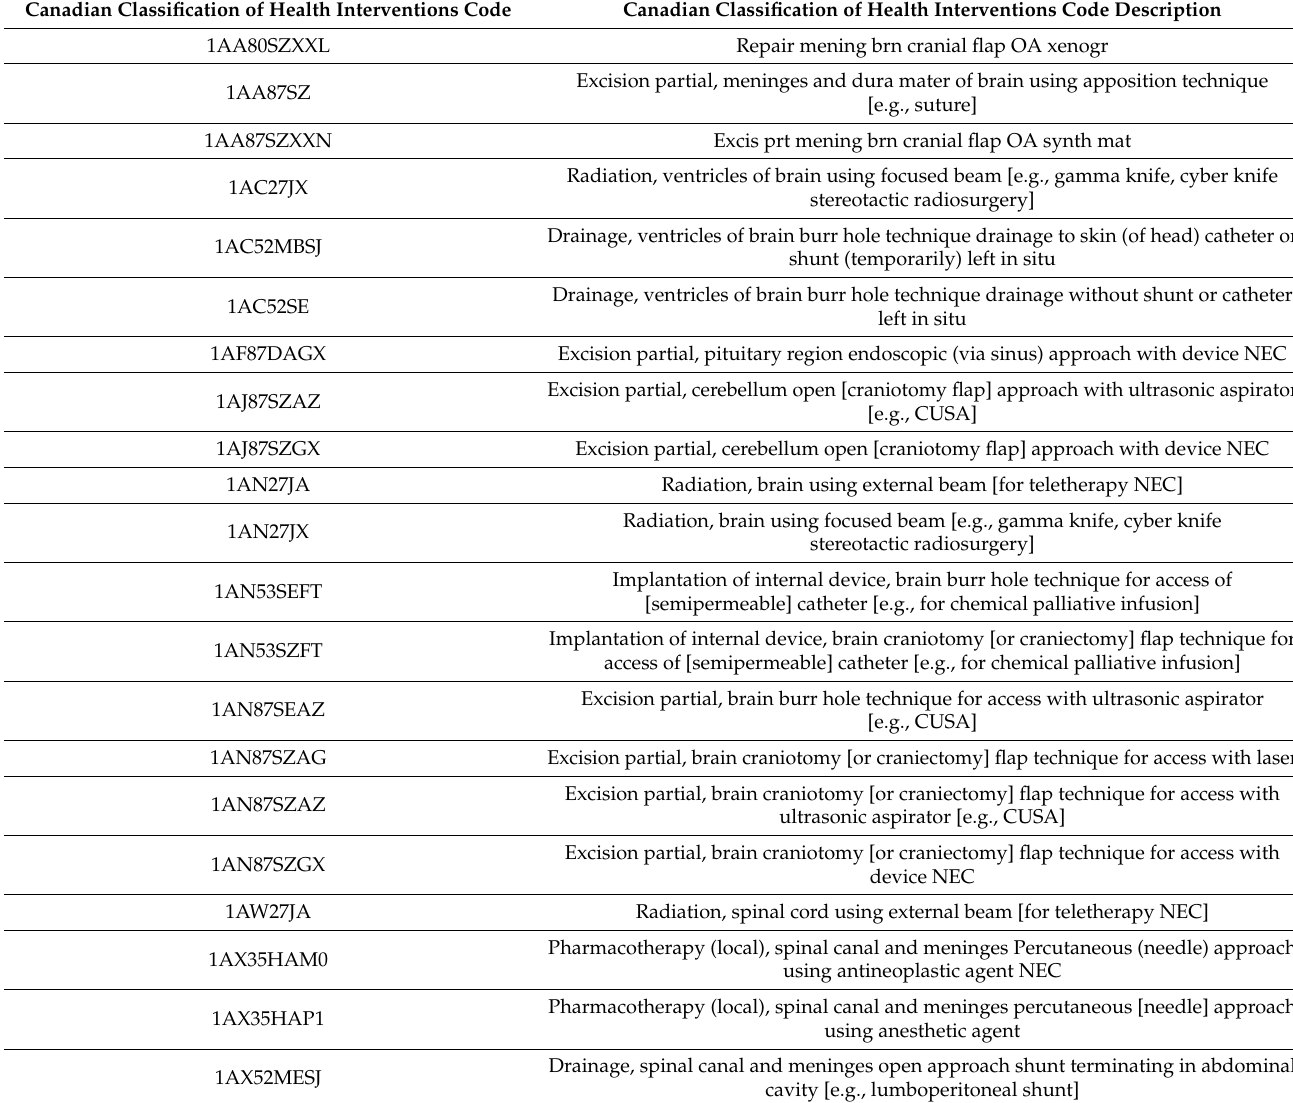
Table A2. Procedure codes for the procedure and associated diagnosis